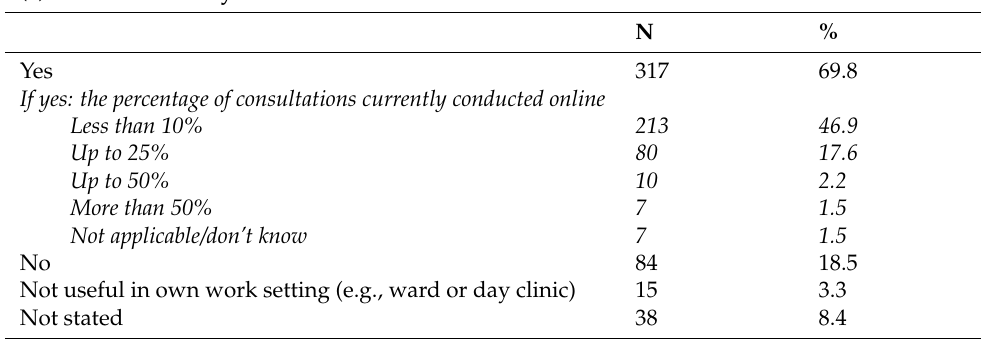
Table 6. Use of telemental